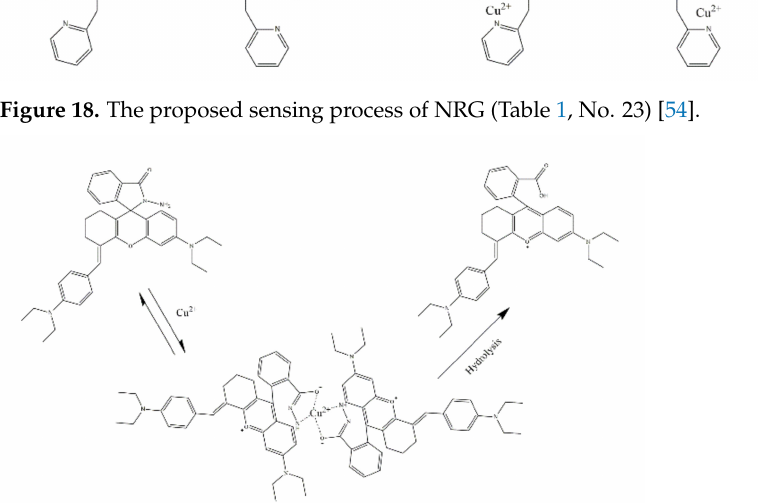
Figure 19. The proposed sensing mechanism of EtRh-N-NH 2 (Table 1, No. 24) [27].